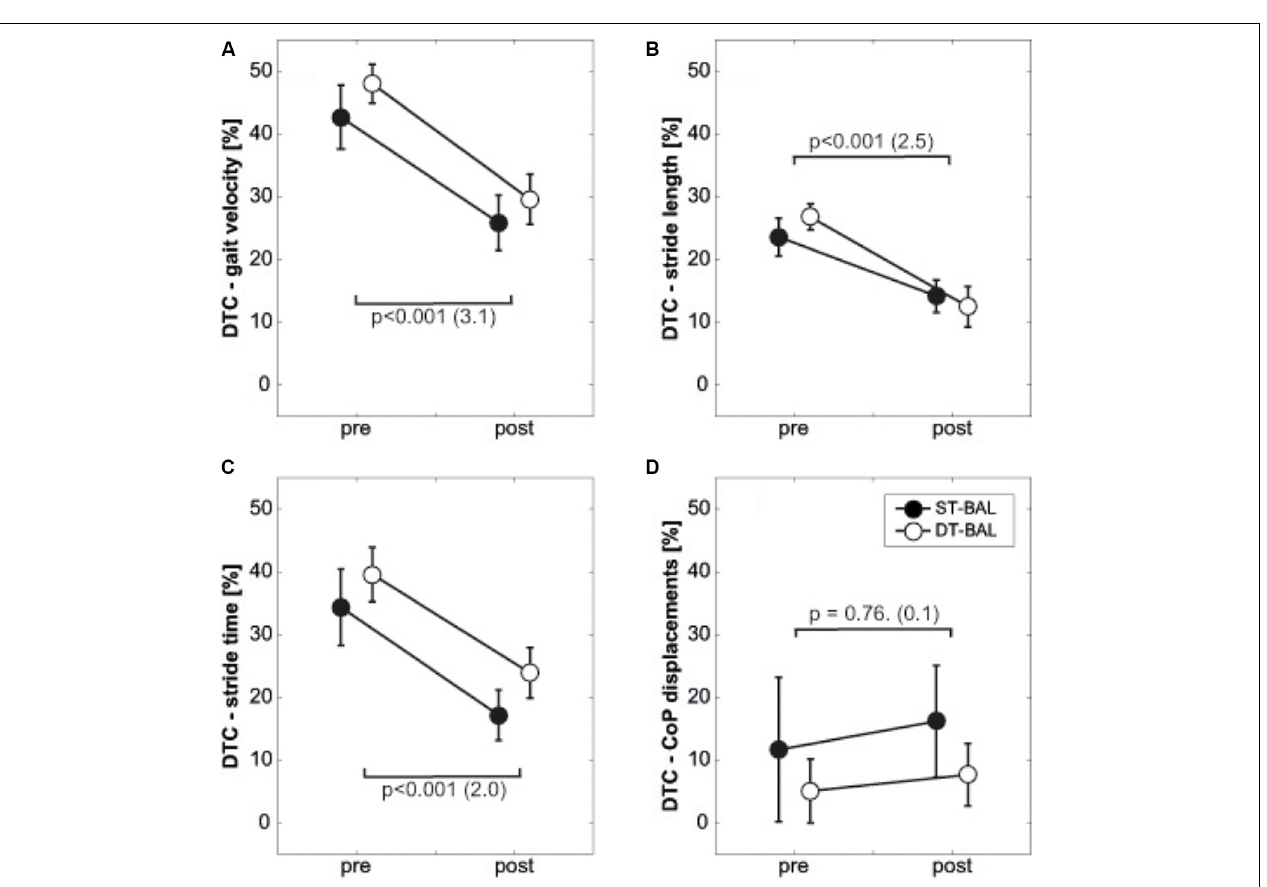
FIGURE 2 | Dual-task costs pre and post intervention, displayed separately for (A) gait velocity, (B) stride length, (C) stride time, and (D) total CoP displacements. Error bars represent the respective standard errors; CoP, center of pressure; DTC, dual-task costs; DT-BAL, dual-task balance training group; ST-BAL, single-task balance training group; p -values indicate the main effect of Time. Values in brackets represent Cohen’s d